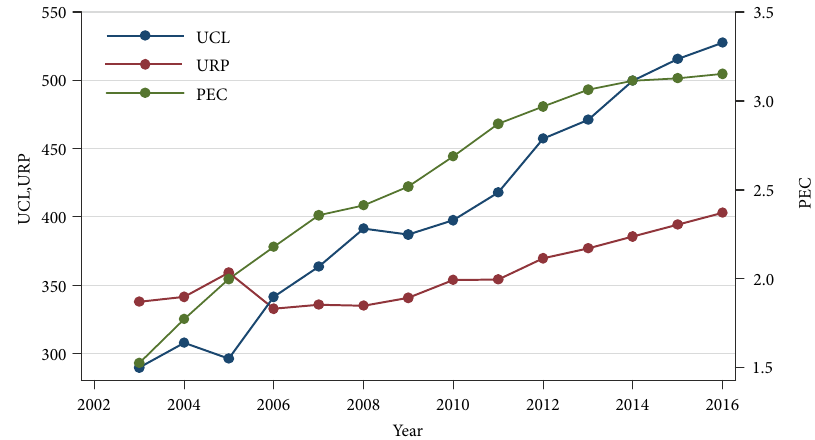
Figure 1. Evolution of UCL, URP and PEC in China over 2003–2016